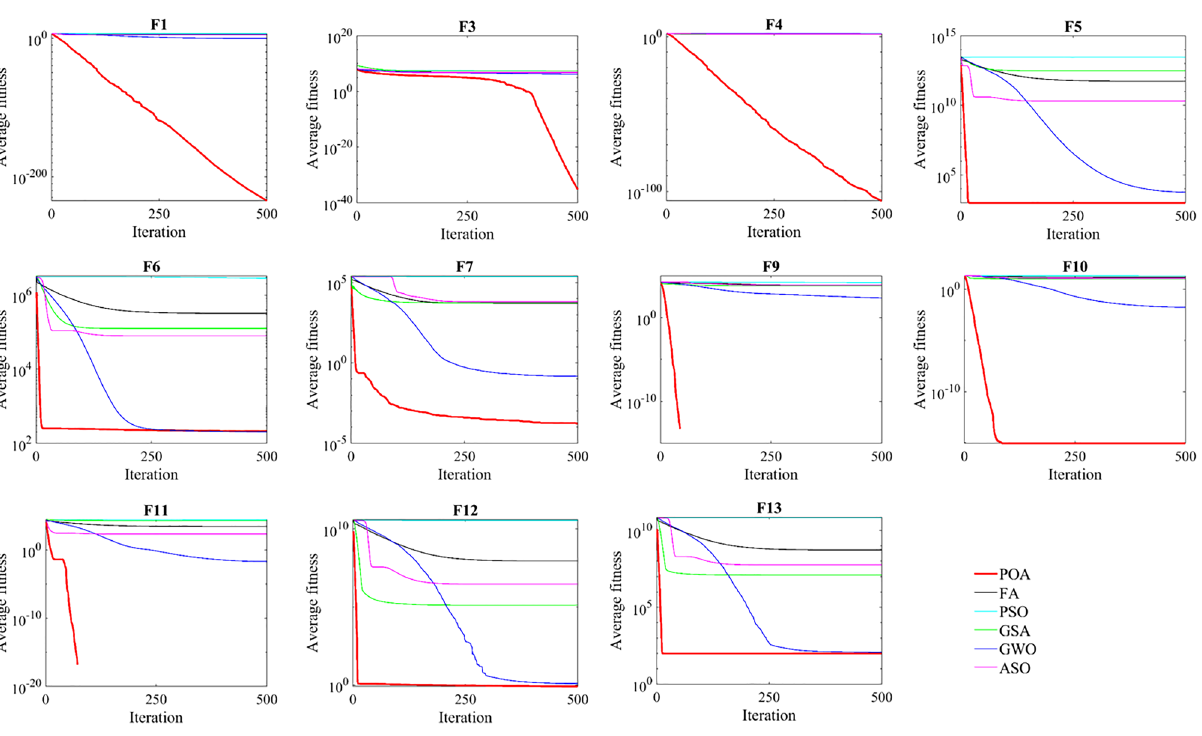
Figure 7. Performance comparison of